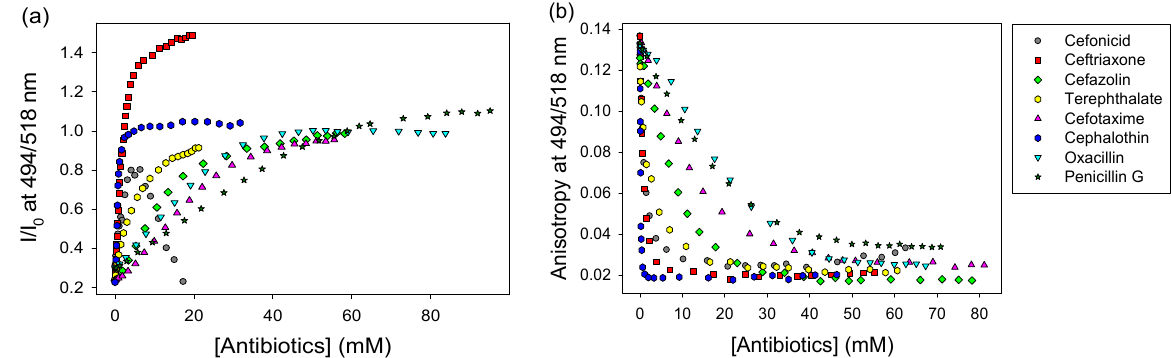
Figure 2. Binding of antibiotics and terephthalate to PAMAM G5 using calcein as an indicator. Titration profiles of analytes of interest into [calcein•PAMAM] complex. ( a ) Fluorescence emission intensity; ( b ) fluorescence anisotropy. [calcein] = 6.36 μ M, [PAMAM G5] = 2.13 μ M, excitation: 494 nm. Performed in 50 mM aqueous HEPES buffer at pH 7.4, T = 25 °C.